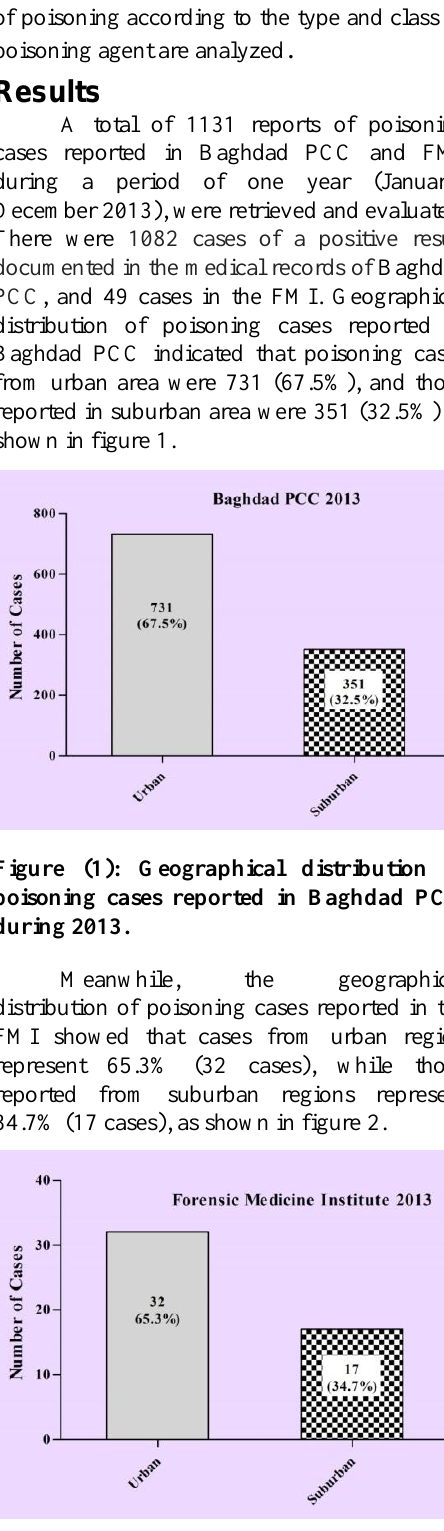
Figure (2): Geographical distribution of poisoning cases reported in the Forensic Medicine Institute during